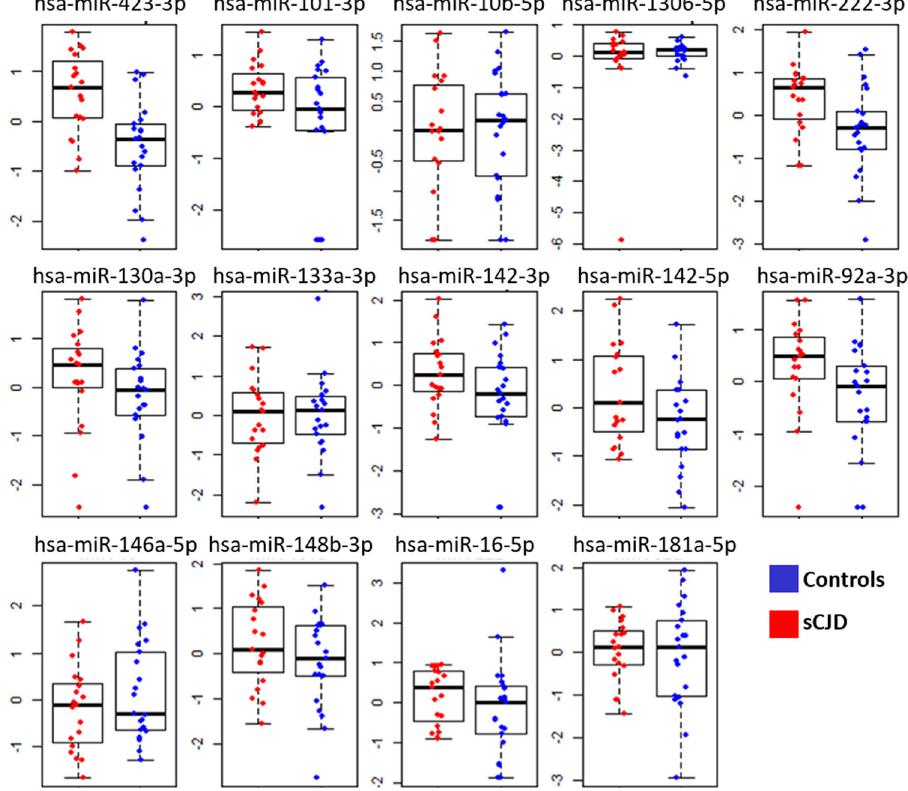
Fig. 5 Box plots showing validated serum EV miRNA differentially expressed in controls and subjects with sCJD. Mean centred and scaled data were plotted between control and sCJD participants. control, n = 20 and sCJD, n =